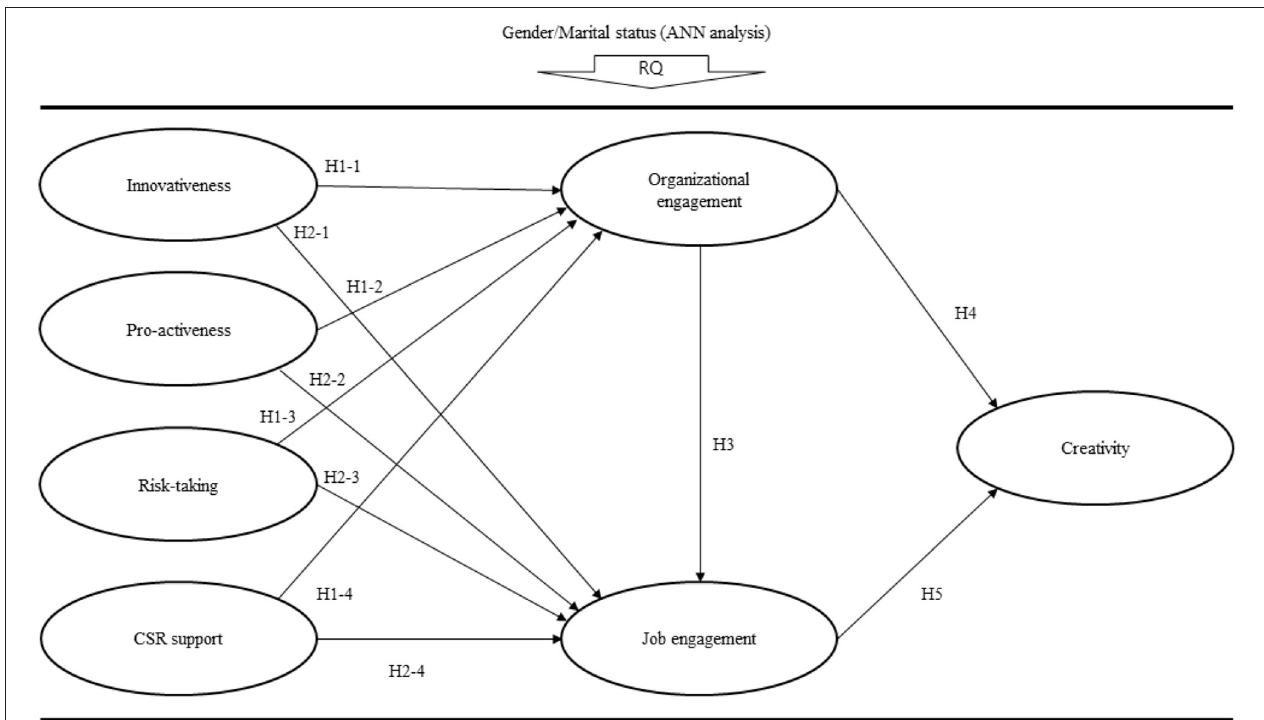
FIGURE 2 | Proposed